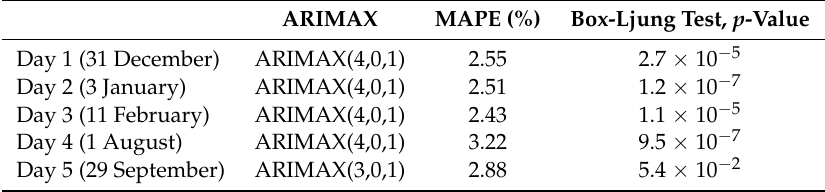
Table 1. Errors achieve by the ARIMAX models for training set, 31 days before the selected